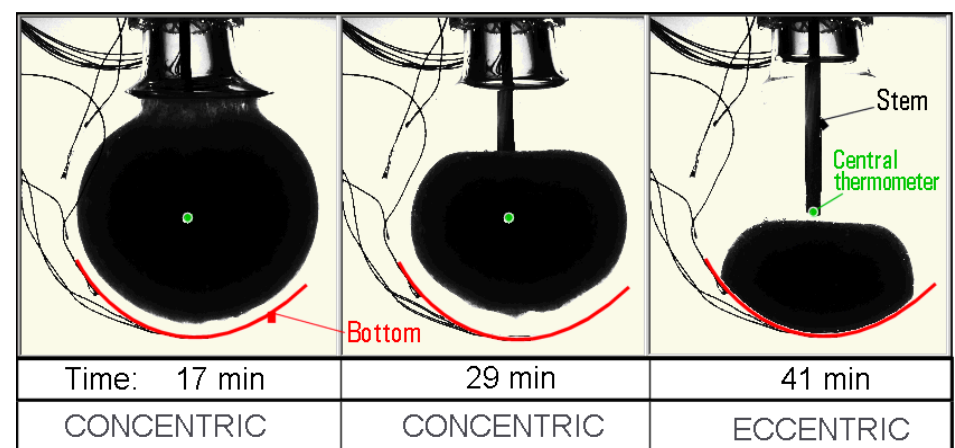
Fig. 19. The initially unexpected change of conditions during the experiment. The failure of the n -eicosane solid body to stay on the stem was initially considered a collapse of the whole experiment (which was too much time-consuming to be repeated). The gradually melted n -eicosane solid body was held from top on the vertical stem. At left, after 17 minutes past the beginning of the melting process, the solid body is still on the stem so that the liquid space (invisible due to the transparency of both glass and melt) is concentric. After added increment of 12 minutes (the central photograph) came the crisis: the body separated from the stem. Later, after another 12 minutes time increment (i.e. at 41 minutes from the start of the process), shown at right, the separated body sits on the shell bottom so that the thermometer initially positioned in the centre of the solid became exposed to the liquid phase. Of course, in the later stages the solid body ceases to be concentric and spherical.